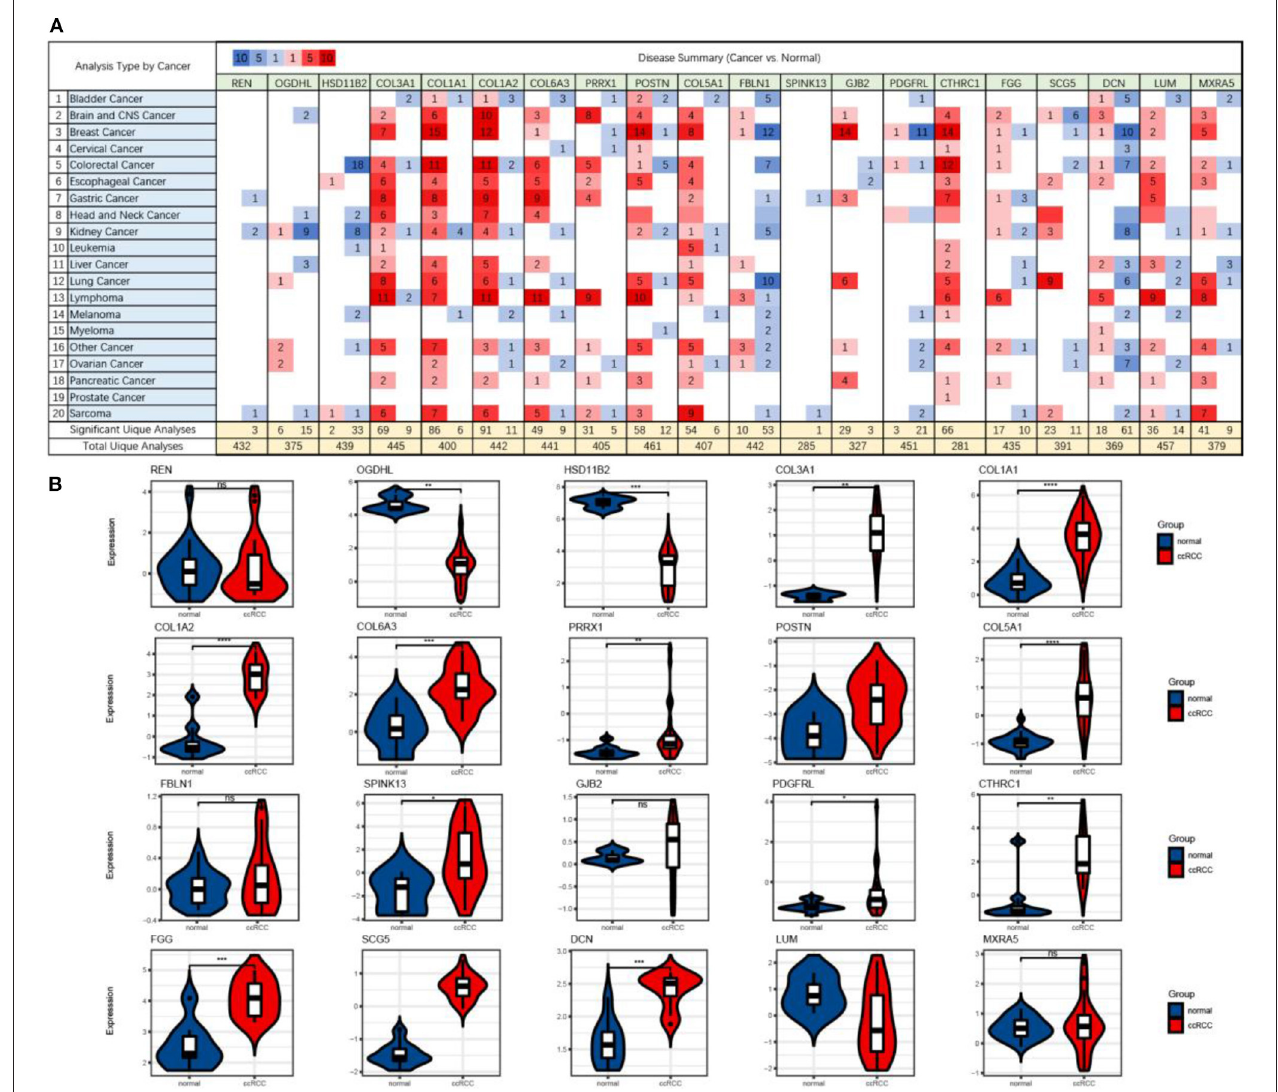
FIGURE 5 | The mRNA expression levels (cancer vs. normal) of shared DEGs in multiple cancer types (A) and ccRCC (B) , which were based on ONCOMINE. The figure shows the numbers of datasets with statistically significant upregulated (red) and downregulated (blue) mRNA